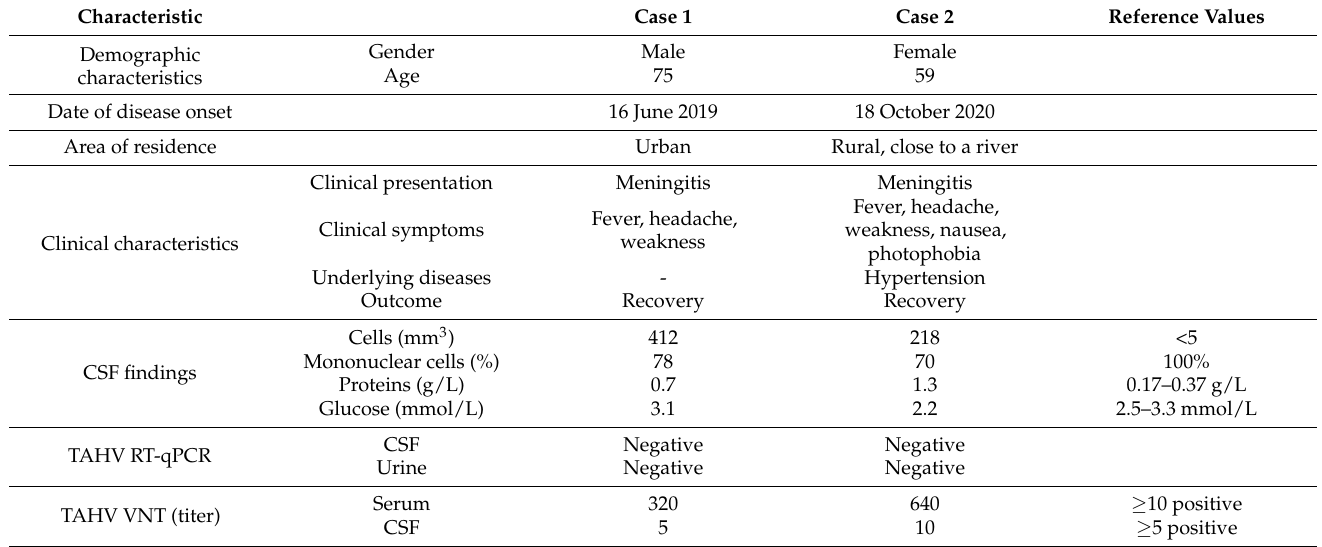
Table 3. Clinical, laboratory, and virology results in two patients with suspected recent Tahyna